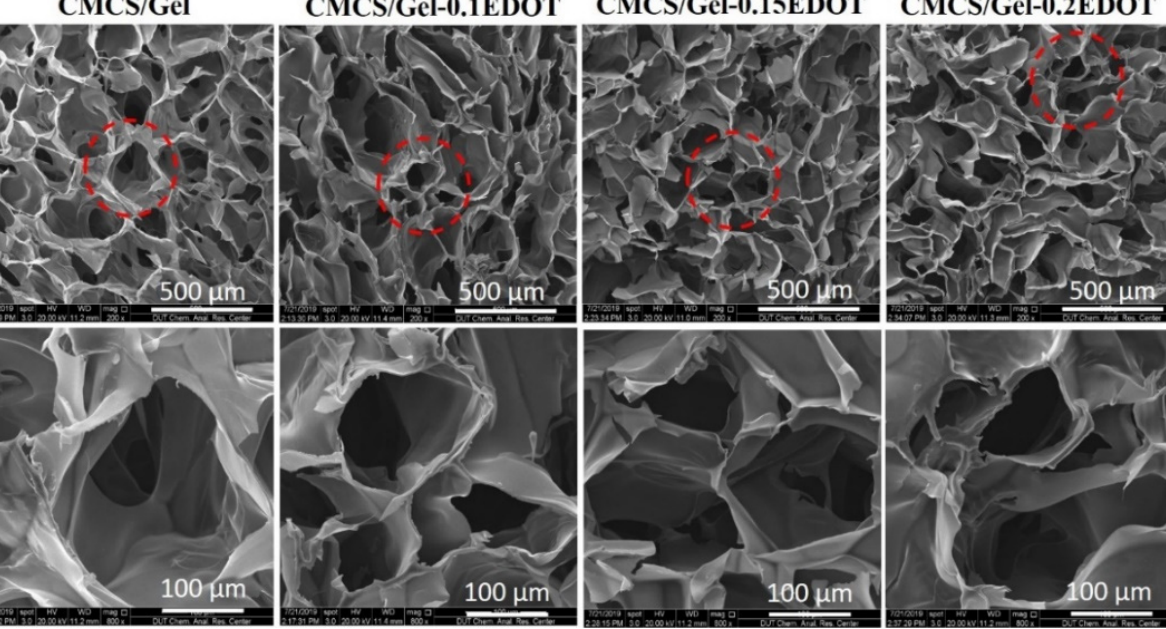
Figure 3. SEM images of CMCS/Gel and CMCS/Gel-PEDOT hydrogels.